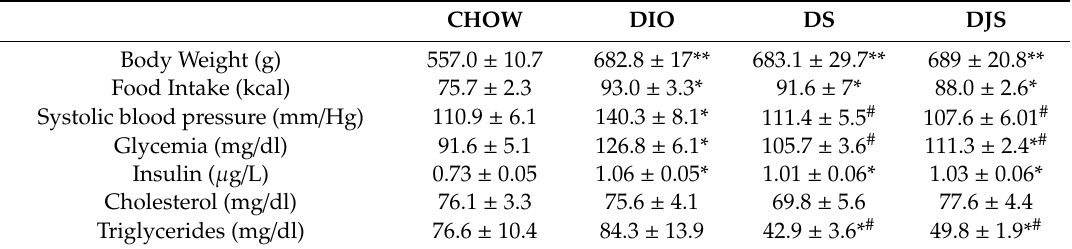
Table 2. Summary of rat parameters on the final day of the experiment. CHOW DIO